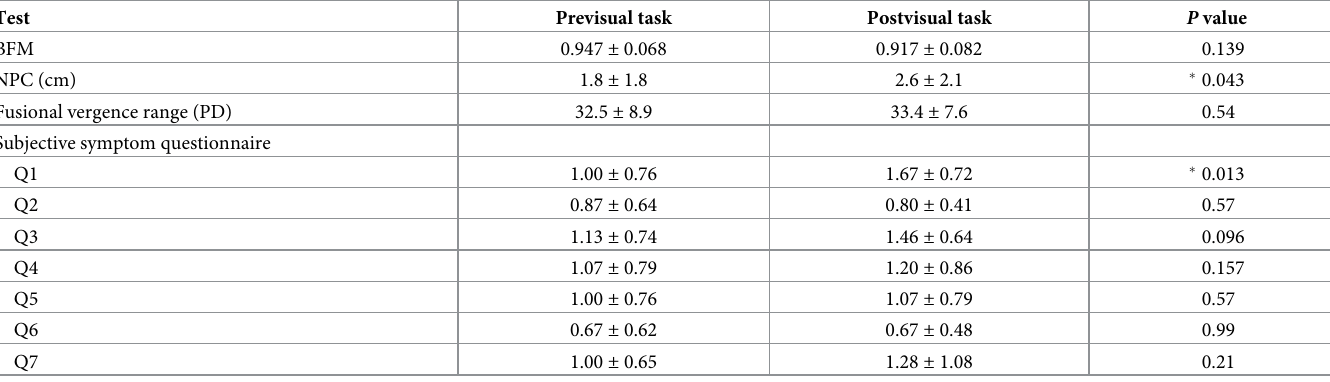
Table 4. Mean results for the control group.